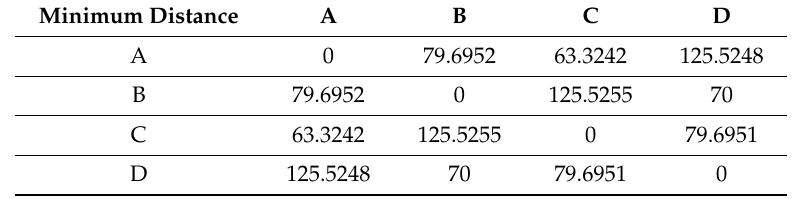
Table 9. Minimum distance between pairs.